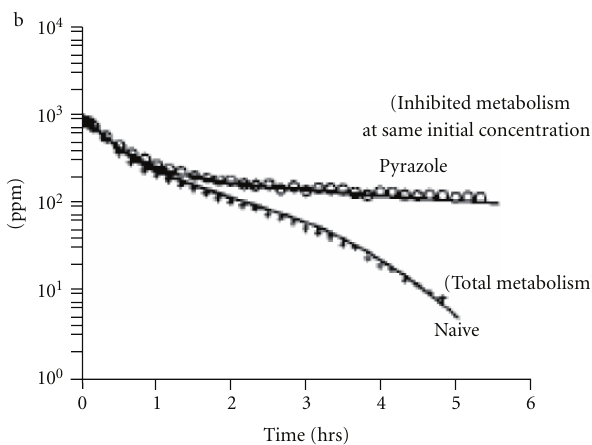
Figure 8: BCM vapor uptake with pyrazole treatment